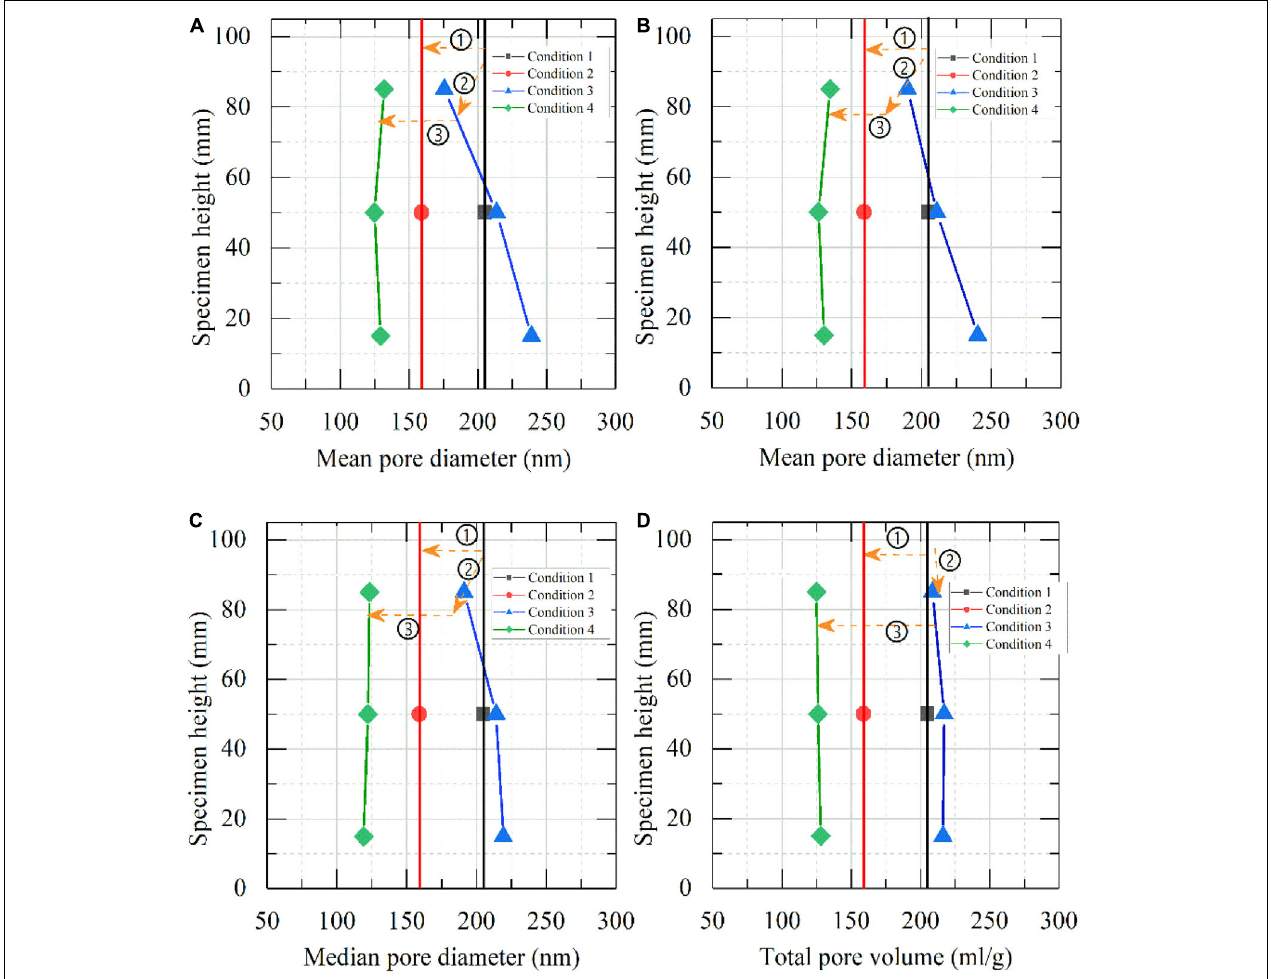
FIGURE 10 | Average pore size distribution for soil samples with condition: (A) undisturbed, (B) after compressing, (C) after freezing-thawing, (D) after freezing-thawing and compressing. (cid:192) Consolidation test, (cid:193) freeze-thaw test, and (cid:194) consolidation test.